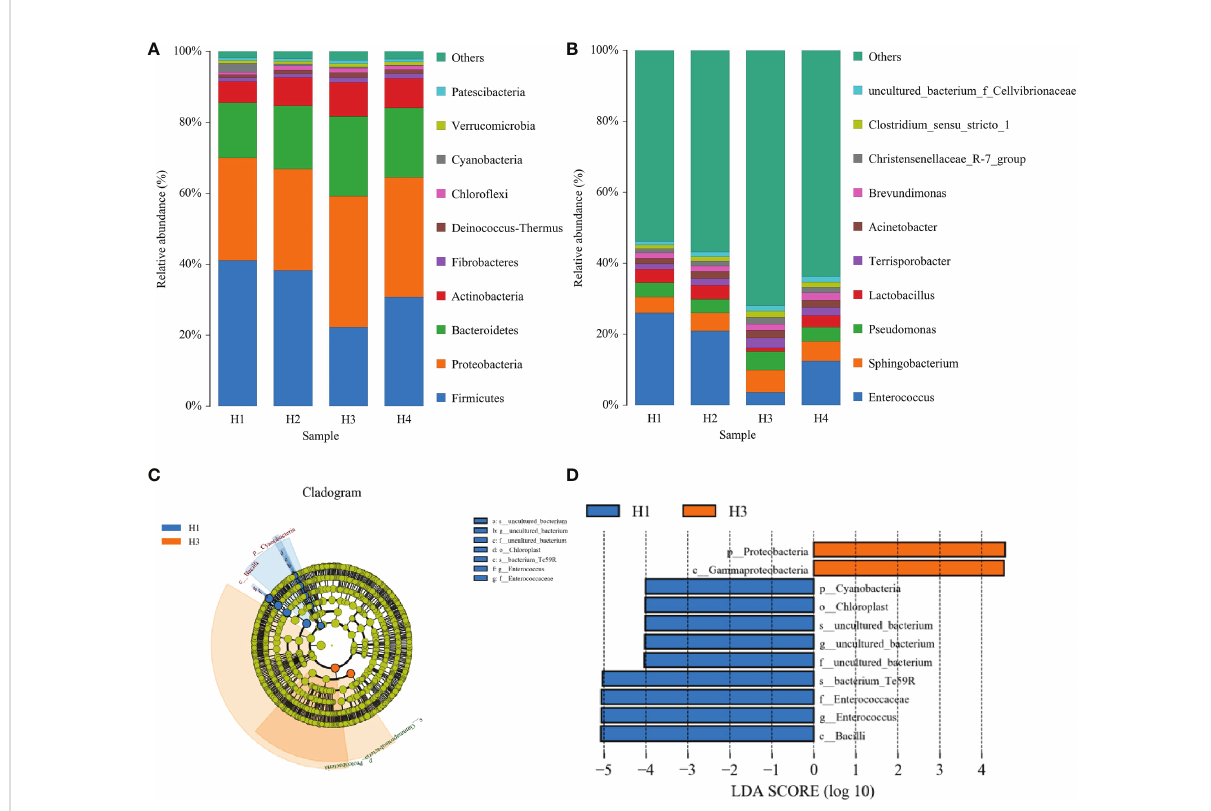
FIGURE 4 The composition (phylum, A and genus, B ) and comparison using the LEfSe online tool (C, D) of the bacterial community of different height Pennisetum sinese